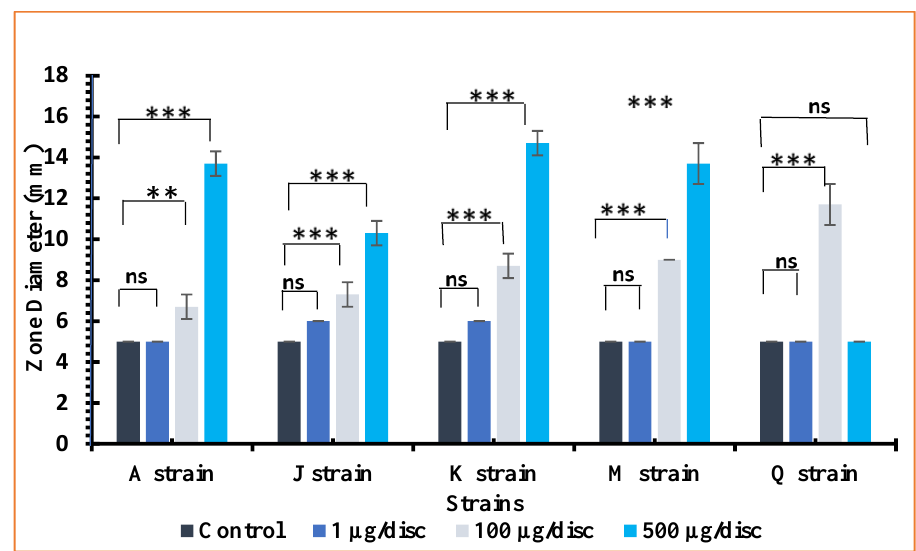
Figure 8. The zone diameter at different concentrations of complex ( 1 ) on Strains Klebsiella pneumoniae ( A ), Staphylococcus aureus ( J ), Streptococcus pneumoniae ( K ), Vibrio cholerae ( M ) & Shigella boydii ( Q ). Data are represented as mean ± SD of three concentration of doses (** p < 0.01, *** p < 0.001, ns—no significance p > 0.05). Table 5. Antibacterial activities of the compounds and standard drugs against three ( − ) ve and two (+) ve bacteria.